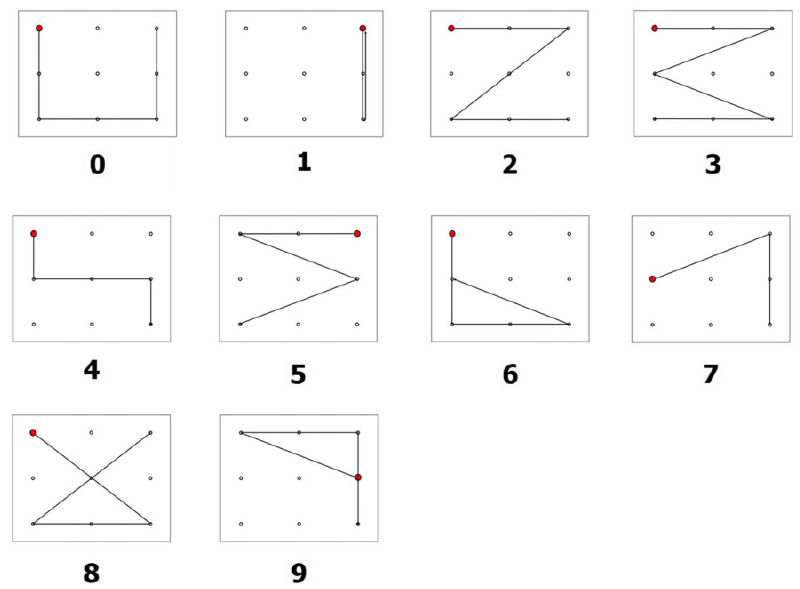
Figure 1. Pattern designs of Arabic numbers [13]. The red dots denote the starting points.